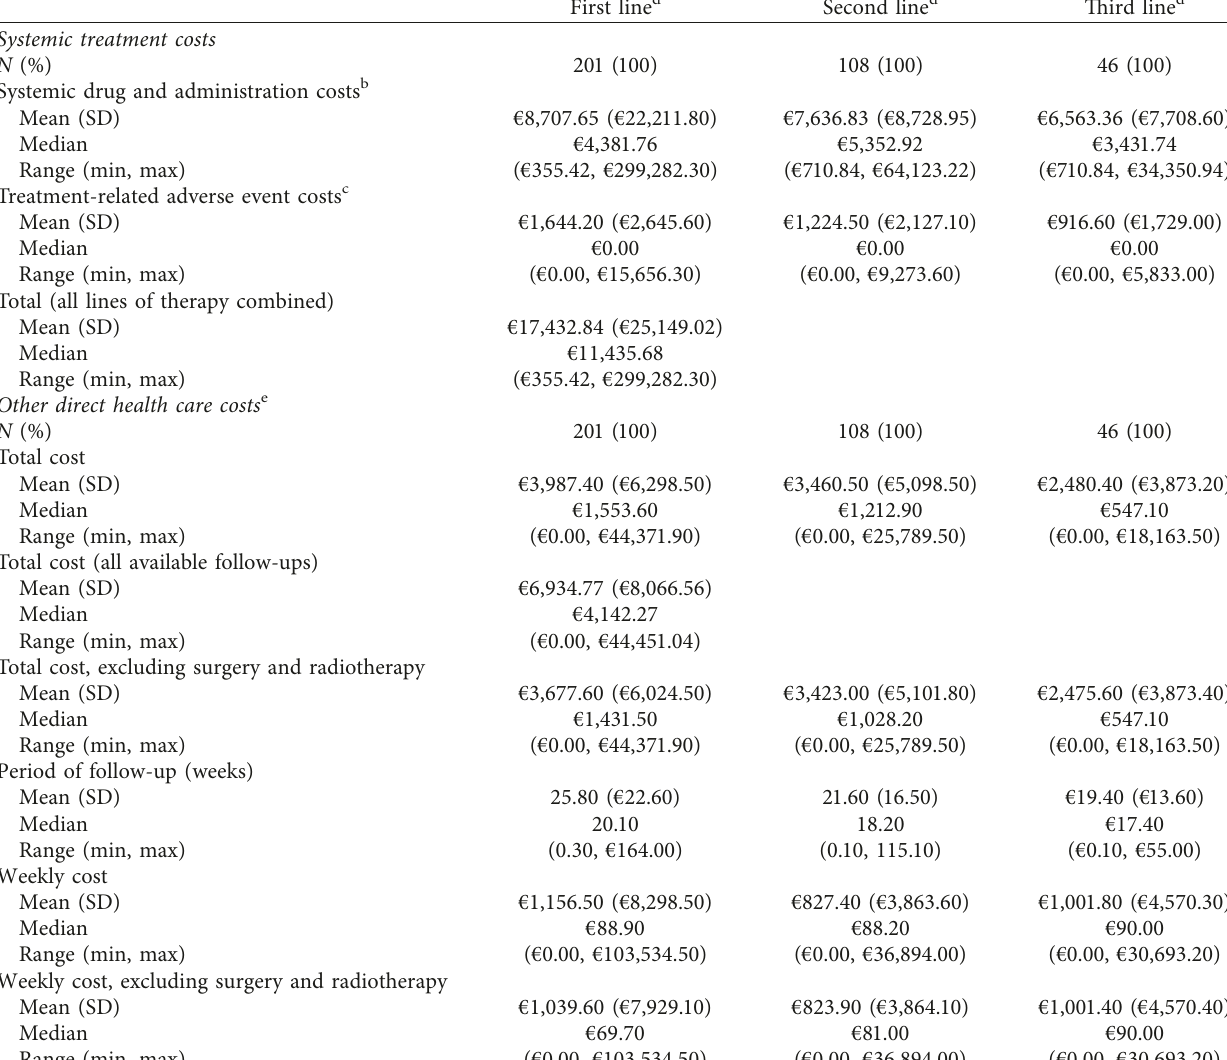
Table 7: Estimated health care costs related to treatment of advanced STS a in France ( n �